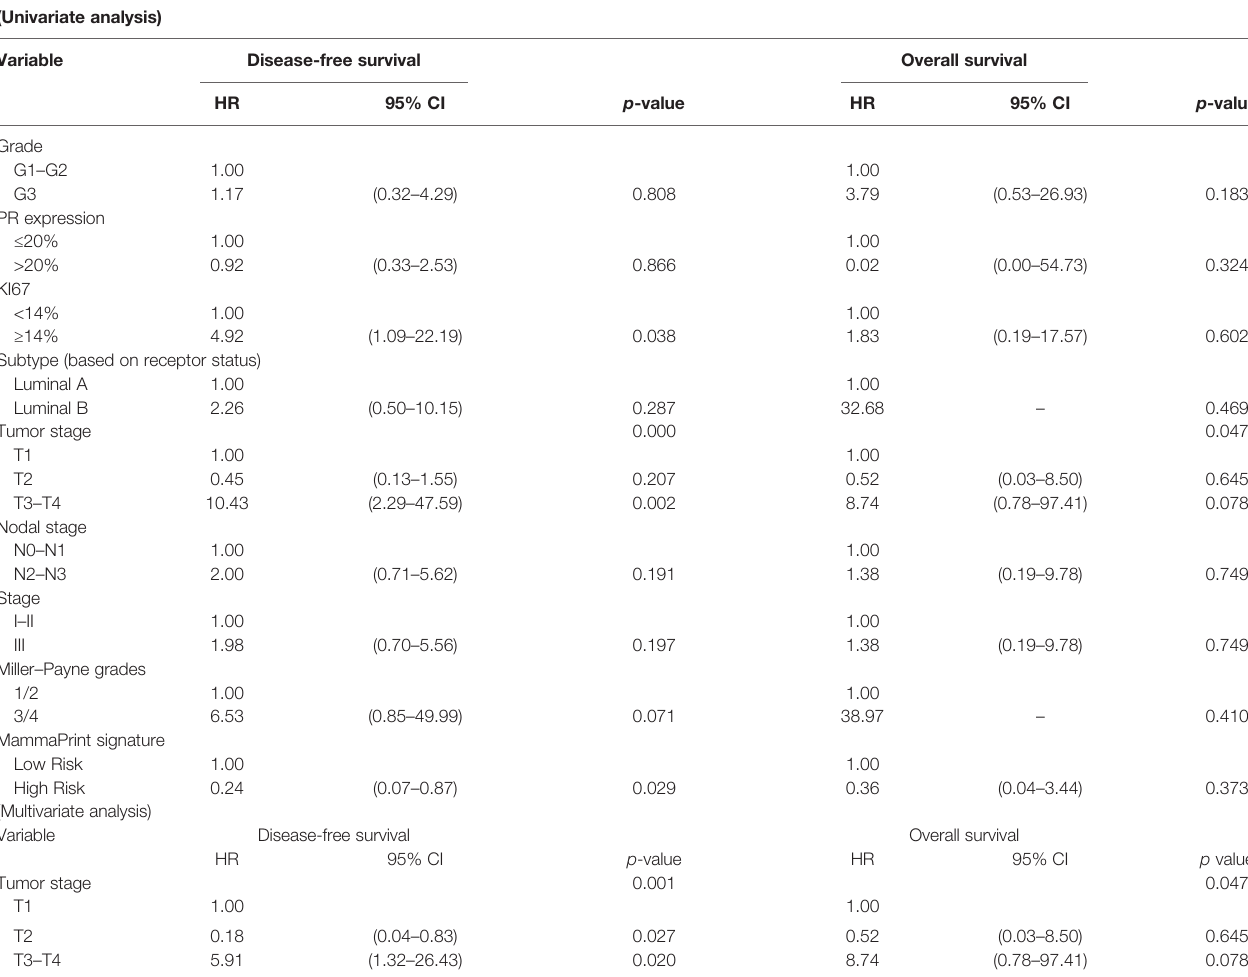
TABLE 5 | Univariate and multivariate analysis of postoperative factors predictive of disease-free survival and overall survival in MammaPrint group. (Univariate analysis)